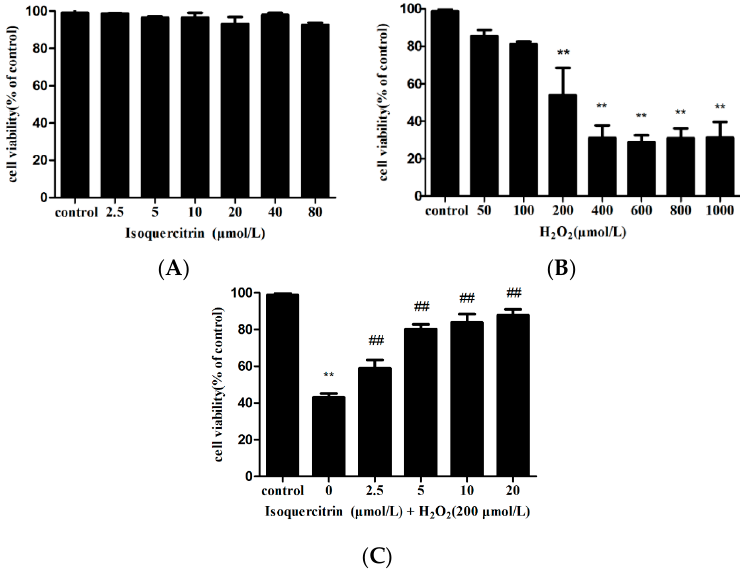
Figure 1. Protective activity of isoquercitrin measured by the MTT assay. ( A ) Cell viability of EA.hy926 cells treated with different concentrations of isoquercitrin; ( B ) Cell viability of EA.hy926 cells treated with different concentrations of H 2 O 2 ; ( C ) Cell viability of EA.hy926 cells treated with isoquercitrin followed by H 2 O 2 treatment. ** p < 0.01 vs. control; ## p < 0.01 vs. H 2 O 2 group.